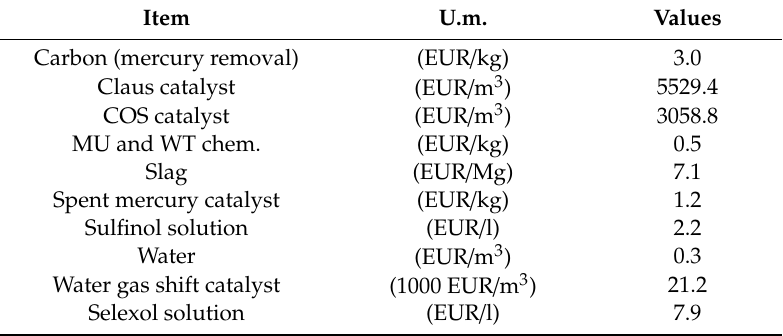
Table 4. Costs of chemicals.